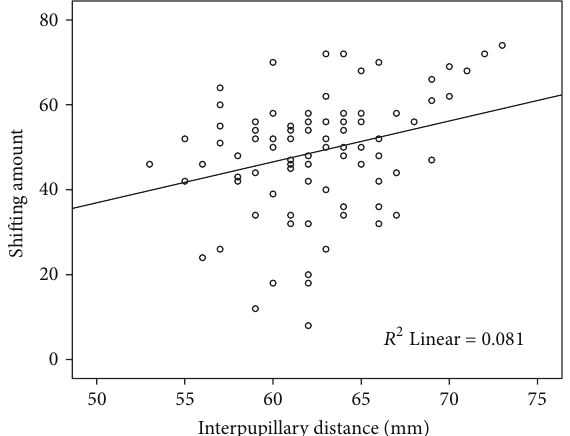
Figure 4: There is a positive correlation with interpupillary distance and shifting in Miles